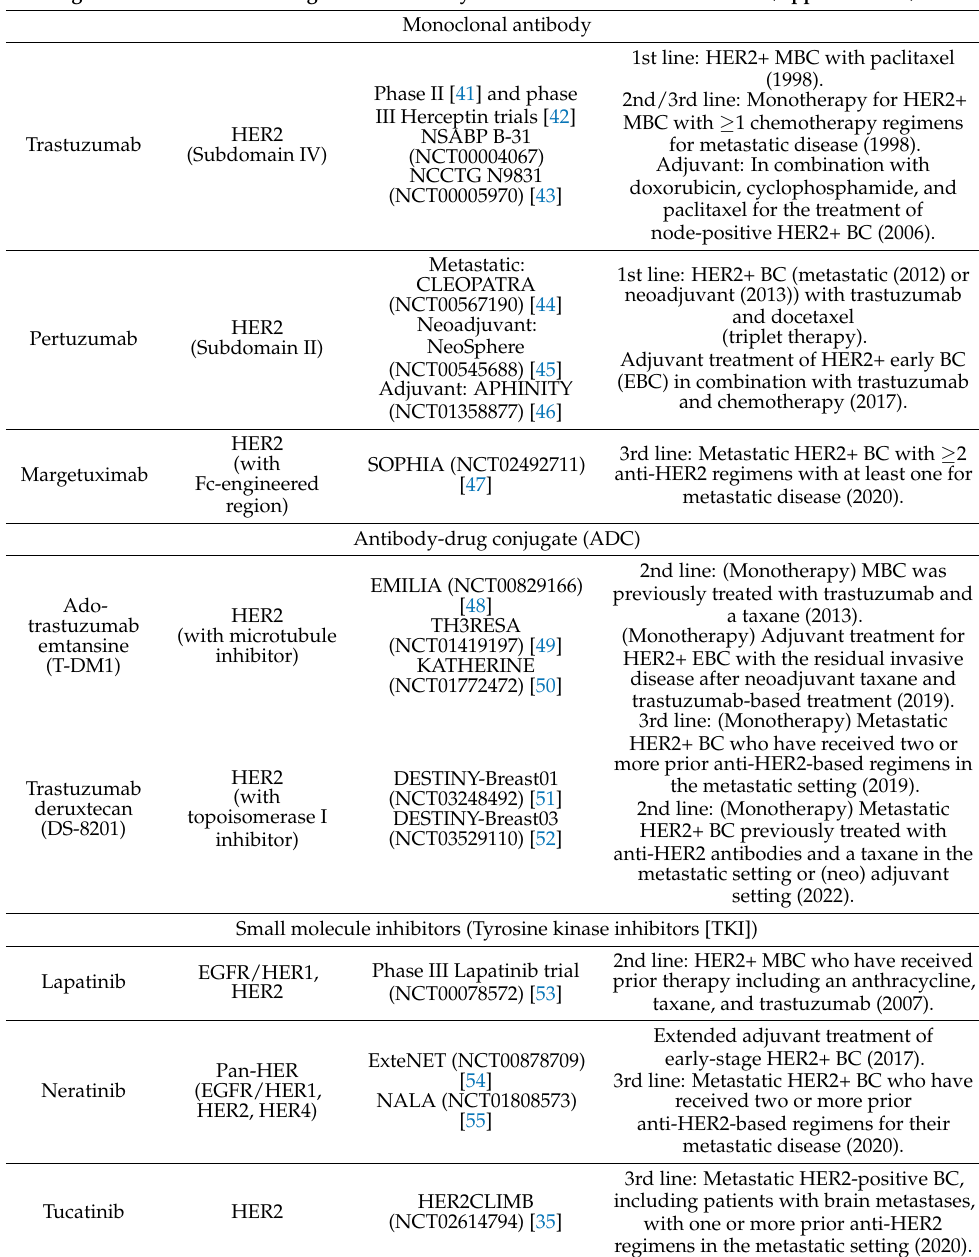
Table 1. FDA-approved molecularly targeted therapies in HER2+